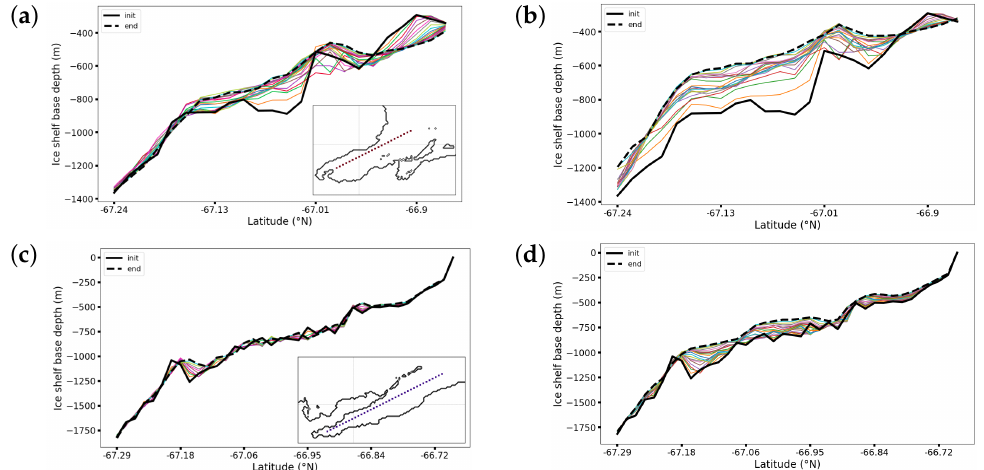
Figure A2. Temporal evolutions of the TIS ( a , b ) and MUIS ( c , d ) base elevation for REF3mcpl ( a – c ) and WARM3mcpl ( b – d ) . Black lines denote the initial ice shelf base elevation, the dotted black lines are the ice shelf base elevation at the end of REF3mcpl and WARM3mcpl. Each colour represents 1 year. The subfigures are the locations of the TIS and MUIS